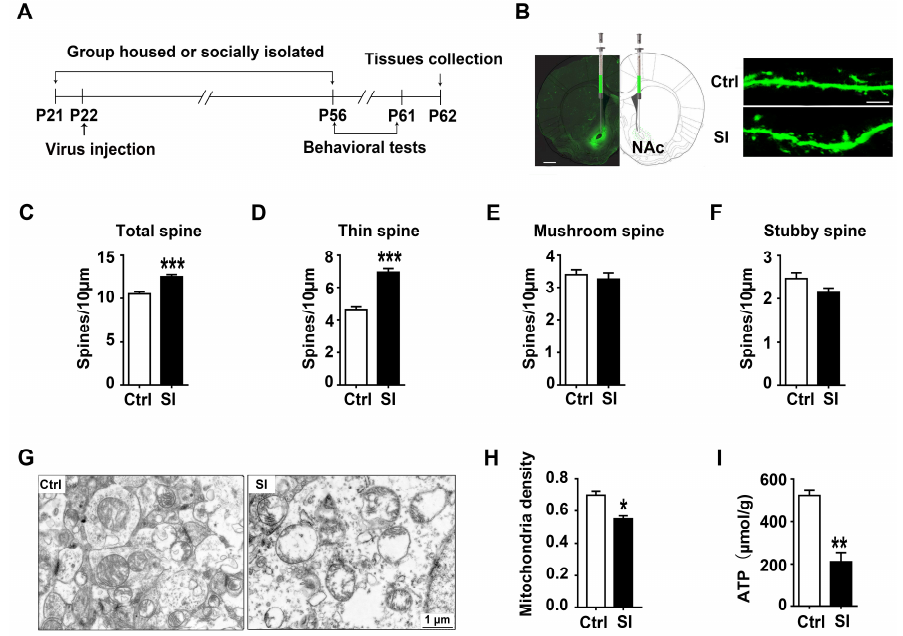
Figure 2. The effect of adolescent social isolation on spine remodeling and mitochondrial function in the NAc: ( A ) an experimental design for the injection of viruses and the collection of tissues; ( B ) representative confocal images of spines in female rats injected with viruses expressing eGFP; left image scale bar equals 1 mm, right image scale bar equals 7.5 μm; ( C ) adolescent social isolation significantly increased the total spine density; ( D ) adolescent social isolation significantly increased the density of thin spines; ( E , F ) adolescent social isolation had no effect on spine density of the mushroom and stubby; ( G ) images of control and isolated rats’ NAc obtained by electron microscopy; scale bars = 1 μm; ( H ) adolescent social isolation decreased the mitochondrial density of the NAc in isolated female rats; ( I ) adolescent social isolation decreased the ATP content of the NAc in isolated female rats. Student’s t-test was used for data analysis. Data were presented as mean ± SEM; *** p < 0.001; ** p < 0.01; and * p < 0.05 compared to the isolated group; Ctrl indicates control; SI indicates social isolation.